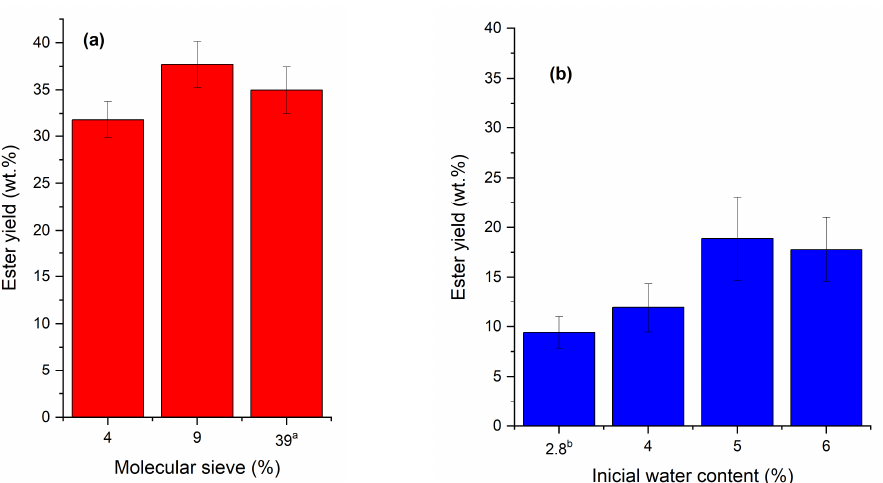
Figure 2. Reaction yields ( Y , wt.%) of esterification/transesterification of SODD with isoamyl alcohol (molar ratio of 1:2.5, 6.0 wt.% of ETL 2.0, 45 °C, and stirring at 250 rpm in a shaker incubator for 12 h) as a function of water content in the reaction medium: ( a ) without added water and using molec ‐ ular sieve (MS); ( b ) without MS and adding water at the beginning of the reaction. a Almost anhy ‐ drous condition throughout the reaction. b Only water content already contained in the reagents and enzyme (without molecular sieve or addition of water).